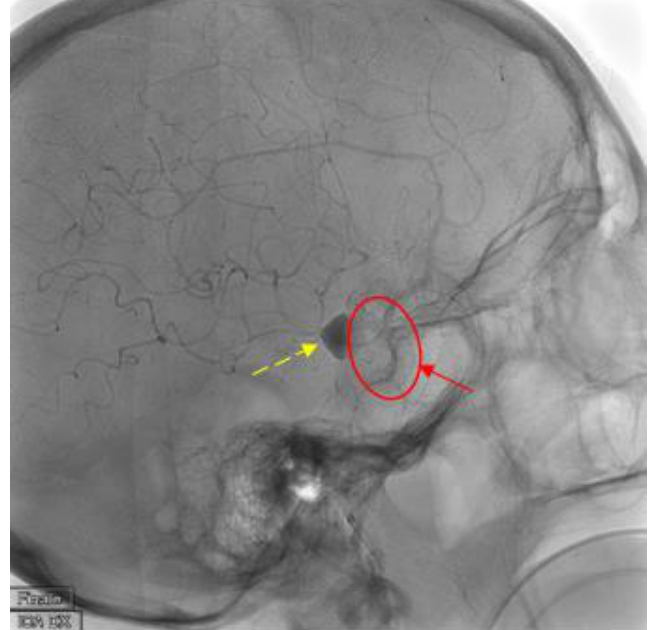
Figure 4. Findings: Latero-lateral view of digital subtracted angiography demonstrates correct placement of the flow-diverter stent (solid arrow and circle) with complete coverage of the aneurysm vessel and contrast medium stasis inside the aneurysm sac (dashed line arrow). Technique: DSA low- dose, 80Kv, 14mAs; 2 frame × second (4 s) 1 frame × second (8 s).